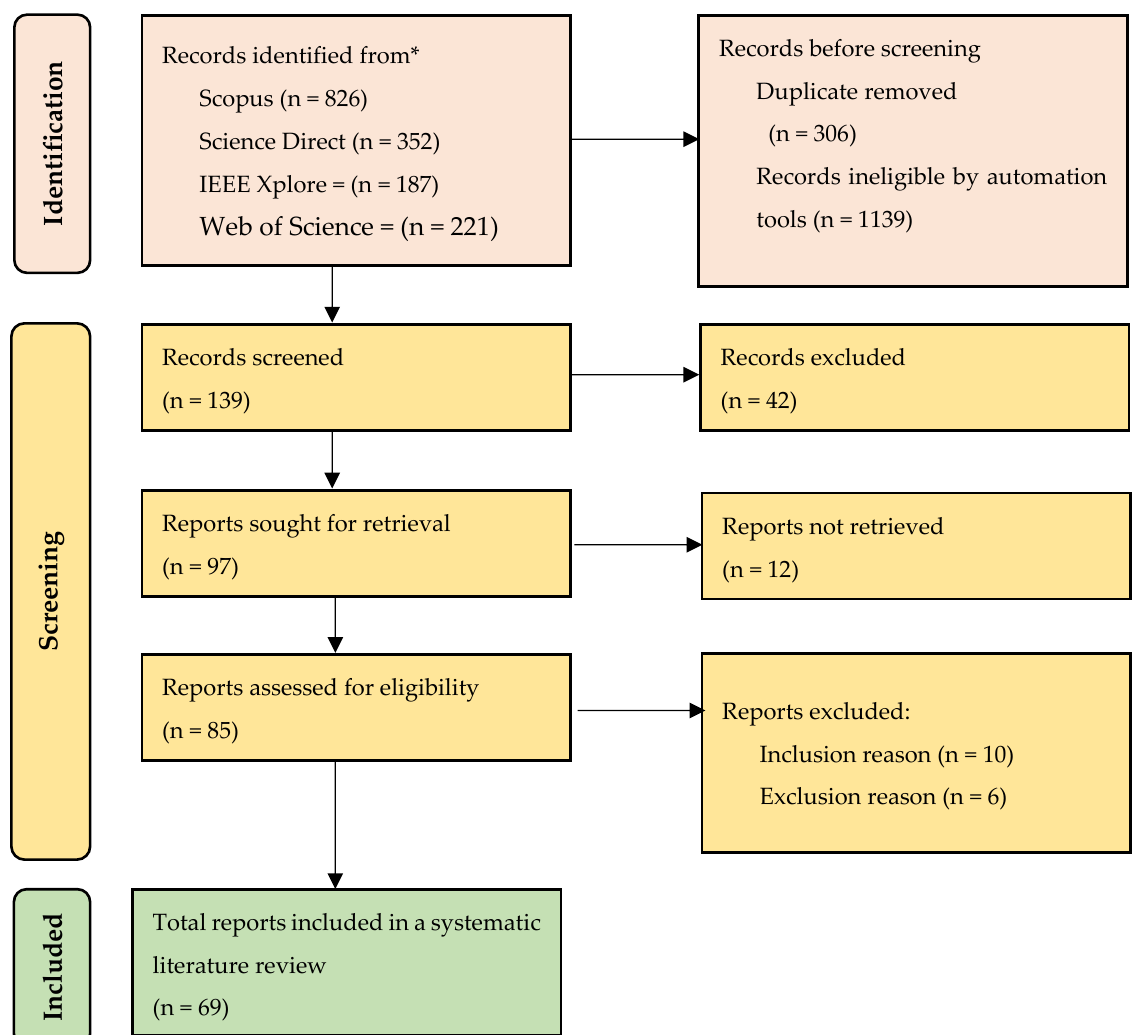
Figure 1. Block diagram selection based on PRISMA flow diagram approach [30]. Table 2. Criteria for the systematic literature review.